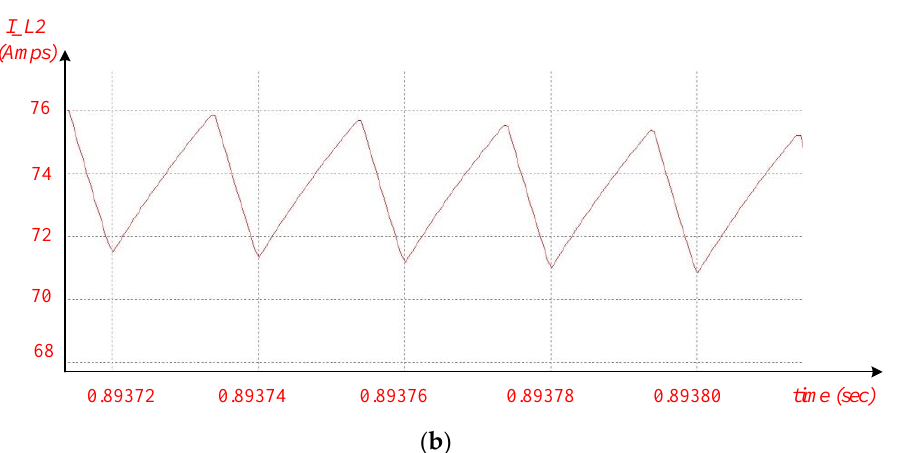
Figure 5. Current waveforms of the inductors: ( a ) L1, and ( b ) L2. Currents through both the inductors, L1 and L2, do not completely cease during a switching cycle and hence prevent the converter from entering discontinuous-conduction mode (DCM).